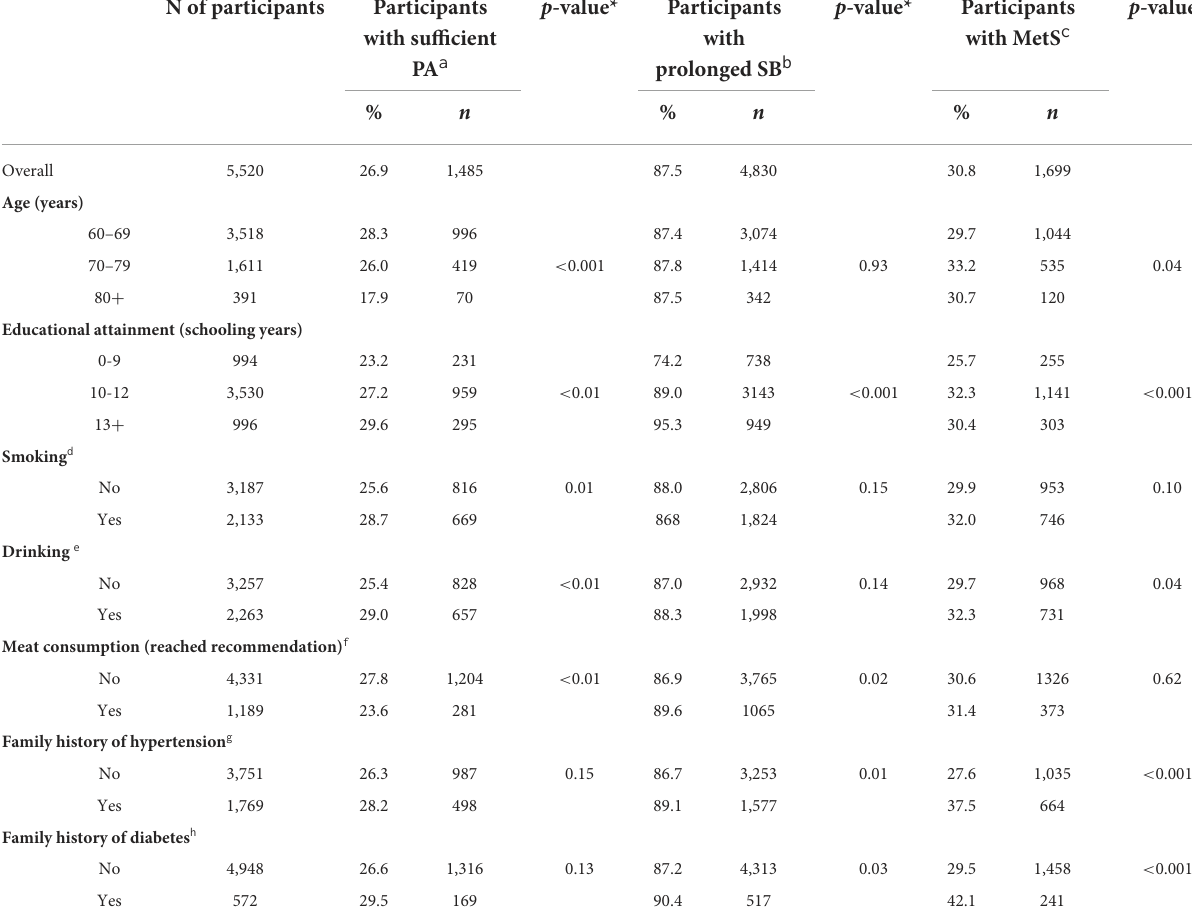
TABLE 2 The proportion of participants by physical activity, sedentary time and metabolic syndrome among urban men aged 60 + years in regional China. p -value* Participants p -value* Participants p N of participants Participants with sufficient with with MetS c PA a prolonged SB b